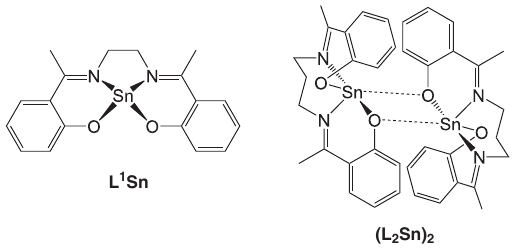
Scheme 4 Steric representation of the conformations of L 1 Sn (monomeric, square pyramidal Sn coordination sphere) and L 2